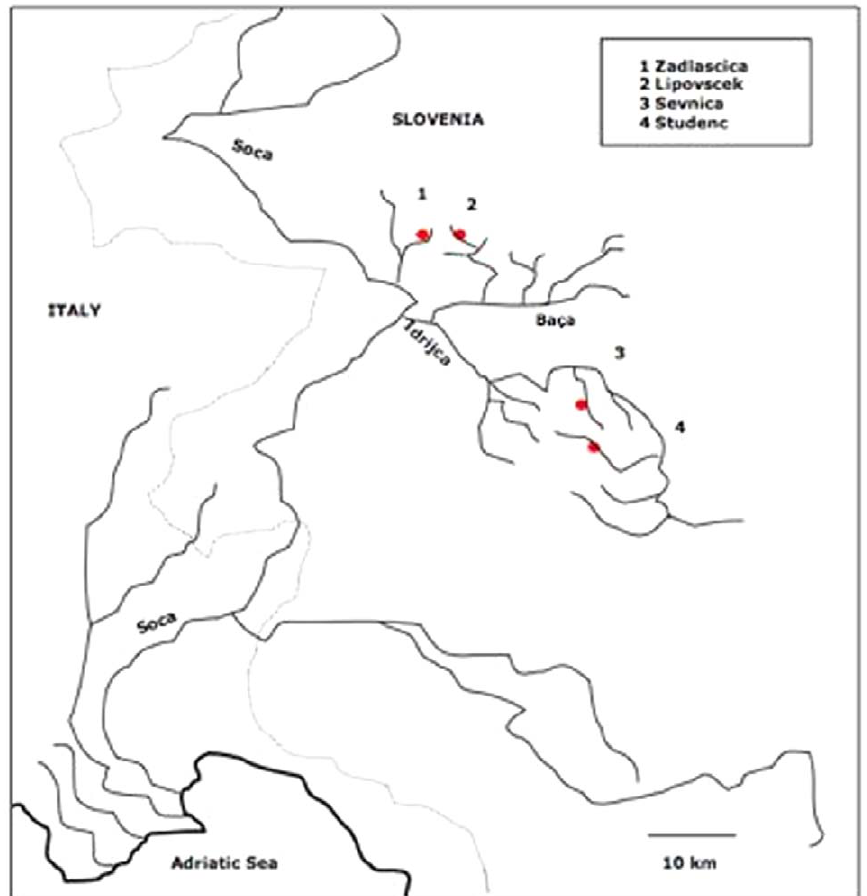
Figure 1. Location of all marble trout sampling locations.